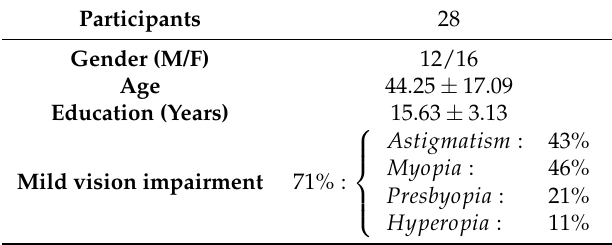
Table 1. Sample’s characteristics; M = male; F =